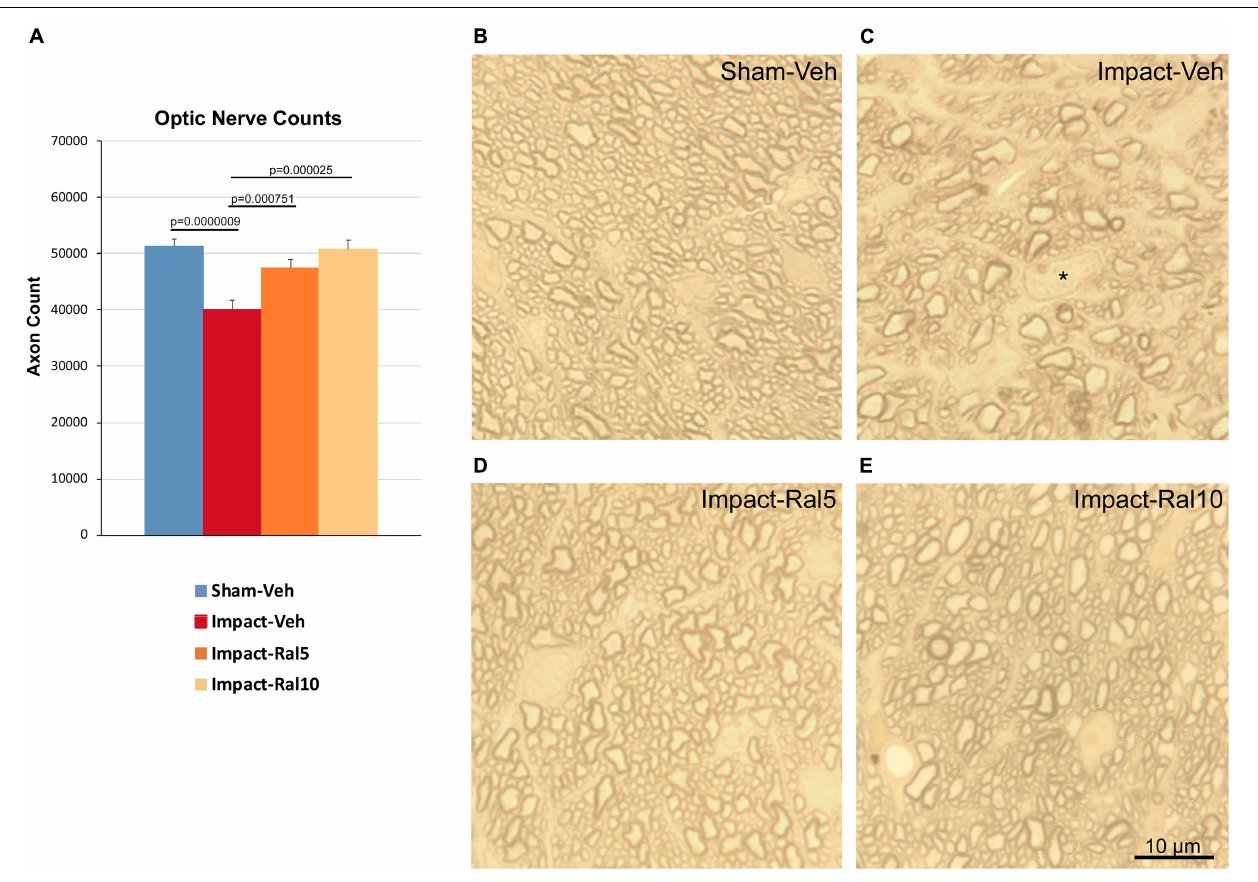
FIGURE 5 | Optic nerve axon loss. (A) Impact-vehicle mice showed a significant 21.8% loss of optic nerve axons compared to sham mice. Treatment with 5 mg/kg raloxifene yielded partial rescue, with only a 7.4% reduction in optic nerve axons, such that axon abundance was significantly greater than for the impact-vehicle mice and only trended toward being significantly different from sham ( p = 0.084). With raloxifene at 10 mg/kg, axon abundance was again significantly greater than in the impact-vehicle mice and indistinguishable from that in sham mice. Errors bars are SEMs. Animal numbers: 21 sham-vehicle mice, 25 impact-vehicle mice, 21 impact-ral5 mice, and 13 impact-ral10 mice. (B–E) High-magnification views of the optic nerve in sham-vehicle, impact-vehicle, impact-ral5, and impact-ral10 mice. The density of axons is obviously lower in the image from the impact-vehicle mouse, and glial cells occupy relatively more space than in the image from the sham mouse. The asterisk in C marks the nucleus of a glial cell. By contrast, axon density in the images from the impact-ral5 and impact-ral10 mice appears similar to that in the image from the sham mouse. Scale bar in (E) applies to (B–E)